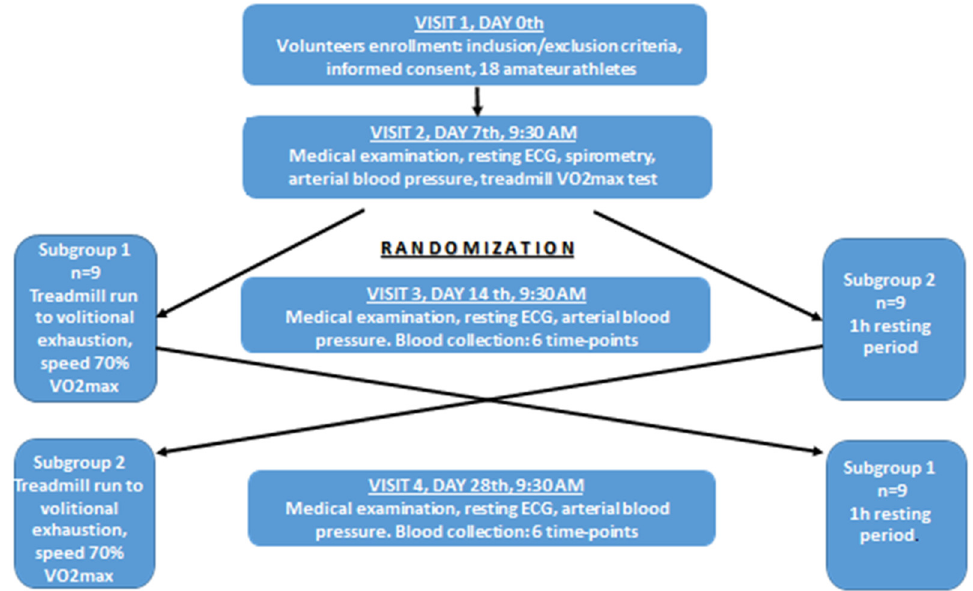
Figure 1. Study design flowchart. Visits 2, 3 and 4 were preceded by four days without any strenuous exercise. ECG–electrocardiography. Spirometry tests involved measurements of FVC (forced vital capacity), FEV1 (forced expiratory volume in the first second), and FEV1/FVC, VO2max–maximal oxygen consumption. Blood was collected six times: before, just after, at 1 h, 3 h, 5 h and 24 h